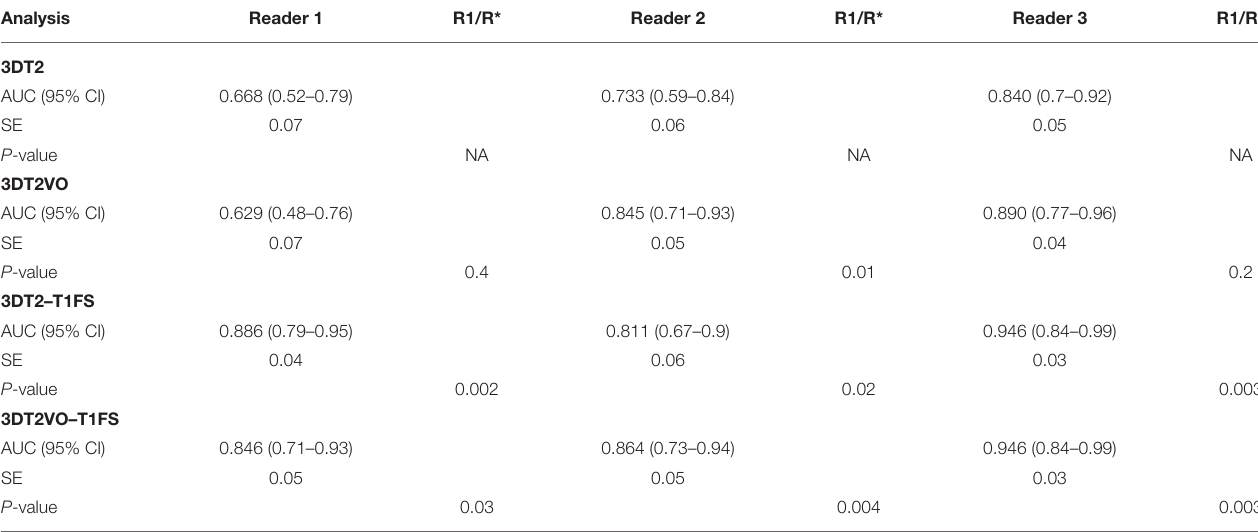
TABLE 4 | Receiver Operating Characteristic (ROC) curve analysis.